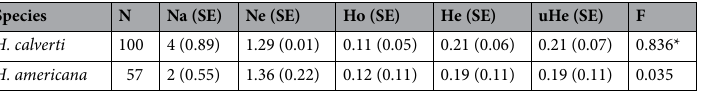
Table 1. Summary of genetic diversity estimators for H. calverti and H. americana individuals in sympatry at Apazapan, Veracruz. N = sample size; Na = mean number of different alleles; Ne = mean number of effective alleles; Ho = mean observed heterozygosity; He = mean expected heterozygosity; uHe = mean unbiased expected heterozygosity; F = mean fixation index; SE = standard error. * p values < 0.0001 after 10,000